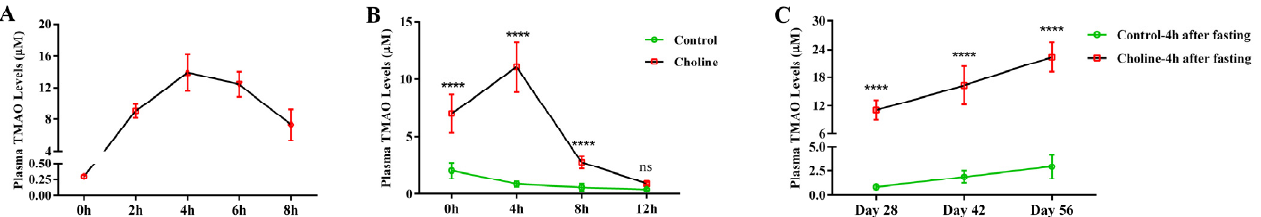
Figure 2. The change of plasma TMAO concentration after different treatments: ( A ) plasma TMAO concentration after intragastric administration of choline chloride, X -axis means different time point after gavage; ( B ) plasma TMAO concentration of different fasting time, X -axis means different time point after fasting; ( C ) plasma TMAO concentration of 4 h fasting at different feeding time. ( B , C ) **** p < 0.0001 versus the control group, “ns” means no significance.